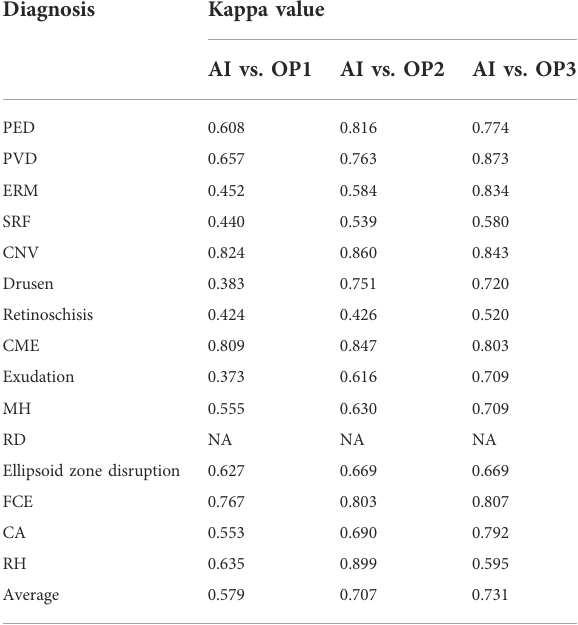
TABLE 3 Kappa analysis